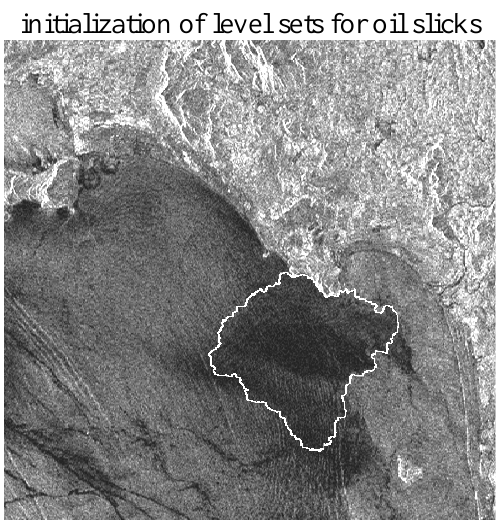
(a) ERS-2 SAR image of the Bohai Sea on June 5, 1996.